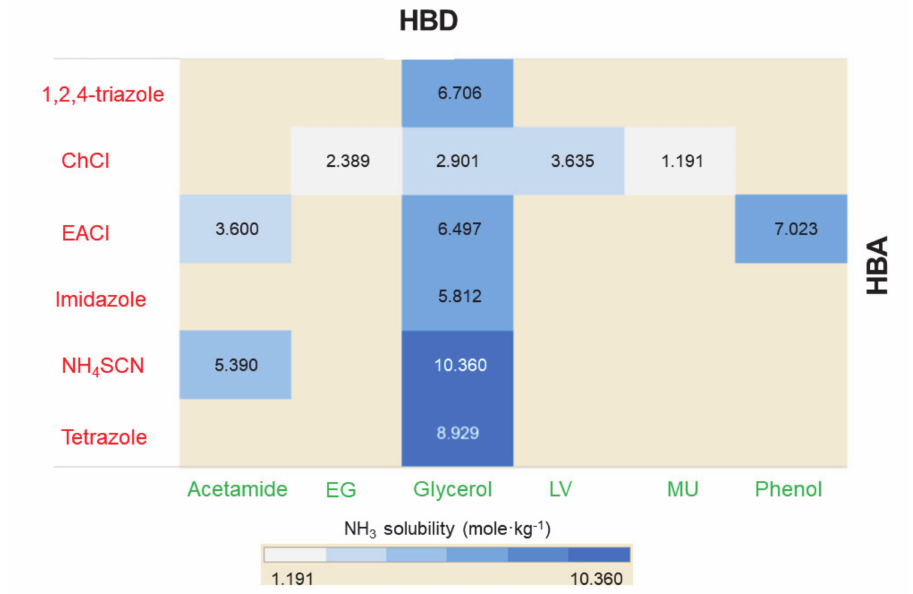
Figure 10. NH 3 solubilities in DESs based on different HBAs and HBDs at 313.2 K and around 0.1 MPa. EACl/gly, 1,2,4-triazole/gly, imidazole/gly, tetrazole/gly were mixed in 1:3 HBA:HBD molar ratio. NH 4 SCN/gly and NH 4 SCN/urea were obtained by mixing in 2:3 molar ratio. All other DESs were prepared in 1:2 molar ratio